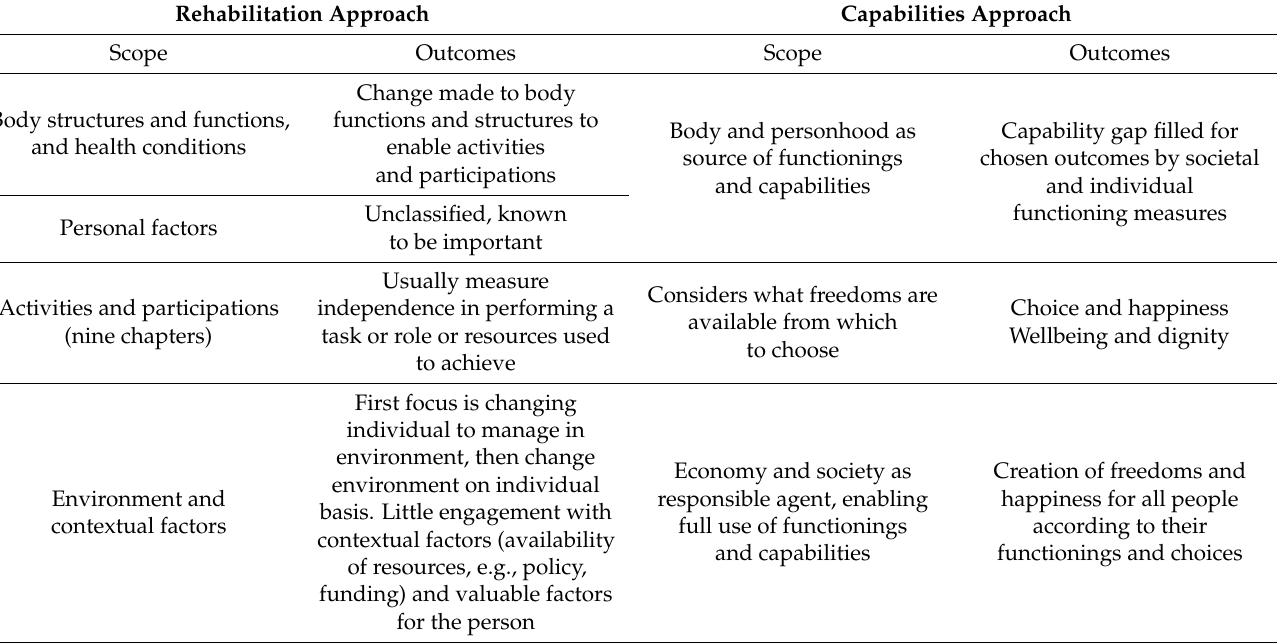
Table 1. Comparison of scopes and outcome arenas of health approach and capabilities